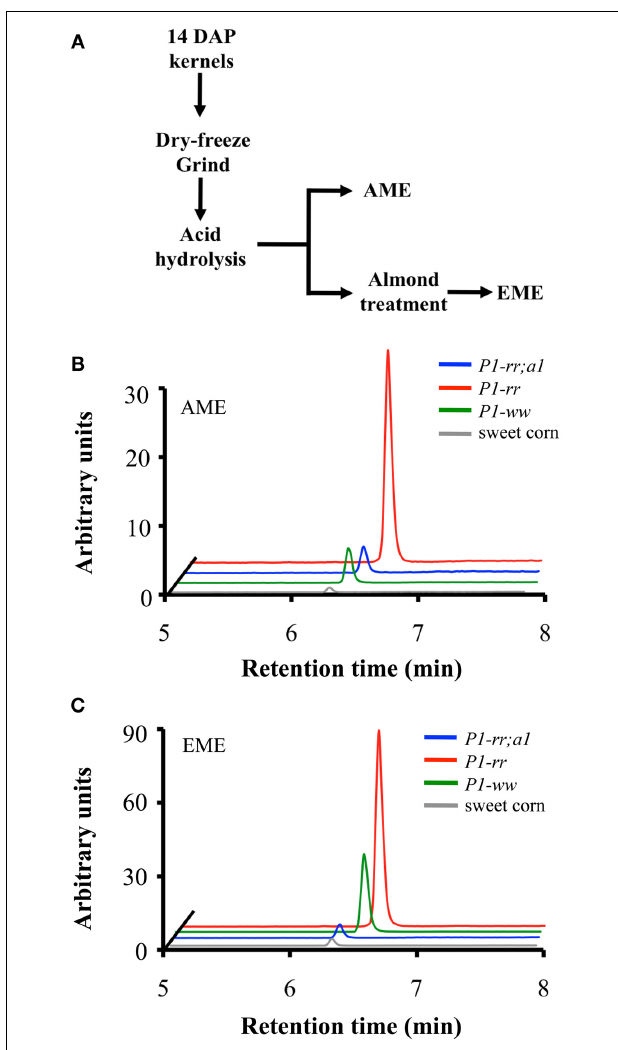
FIGURE 5 | Apigenin content in whole-food maize formulations. (A) Work flow of whole-maize kernel food extract preparation, AME: acid whole maize extract and EME: enzymatically treated whole maize extract. Chromatograms corresponding to apigenin content from P1-rr (red); P1-rr;a1 (blue); P1-ww (green) and sweet corn (gray) in AMEs (B) and EMEs (C) . Arbitrary units correspond to peak intensity for the 268.9/117.0 transitions in counts per